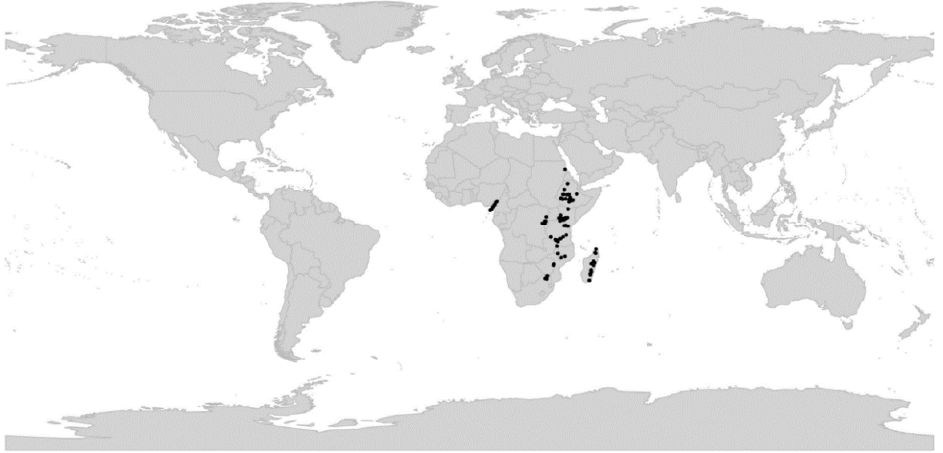
Figure 11. Global distribution of Viola sect. Abyssinium .